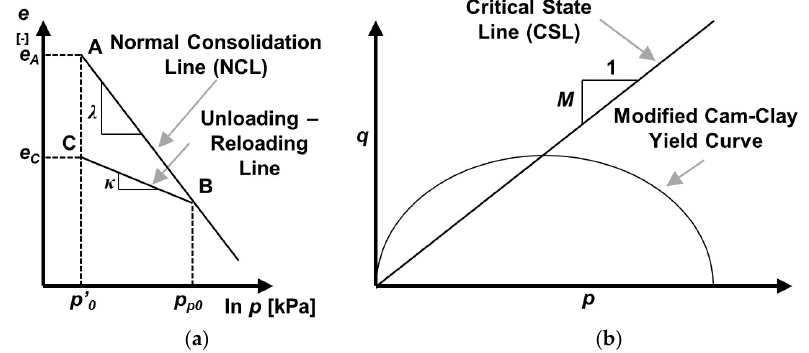
Figure 10. Assumptions of the Modified Cam-Clay model: ( a ) p’-e plane; ( b ) p-q plane.